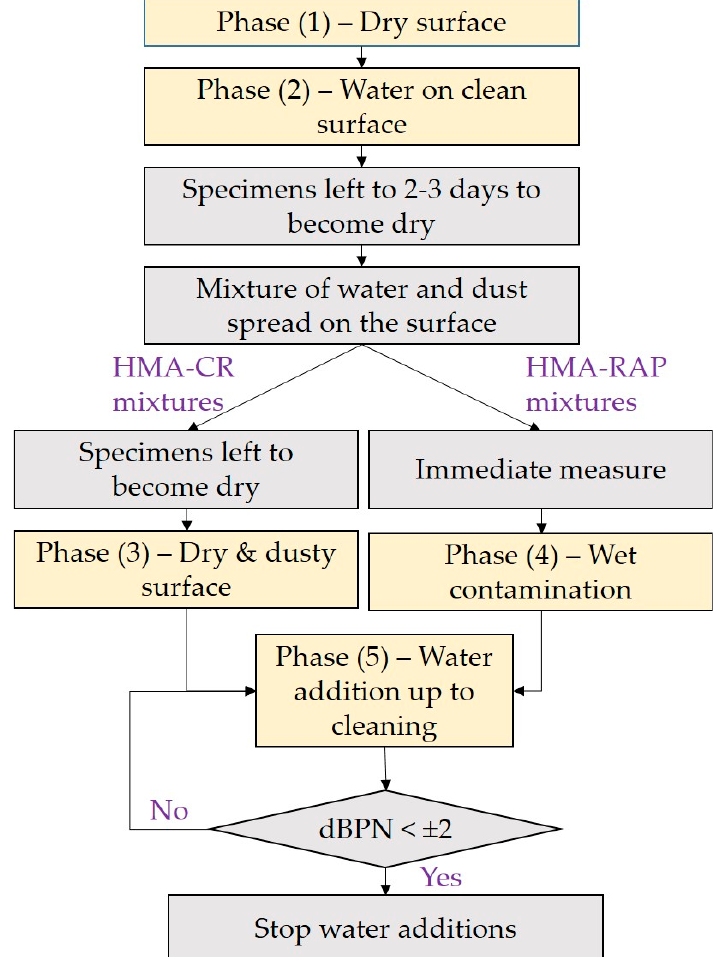
Figure 11. Methodology of the wetting